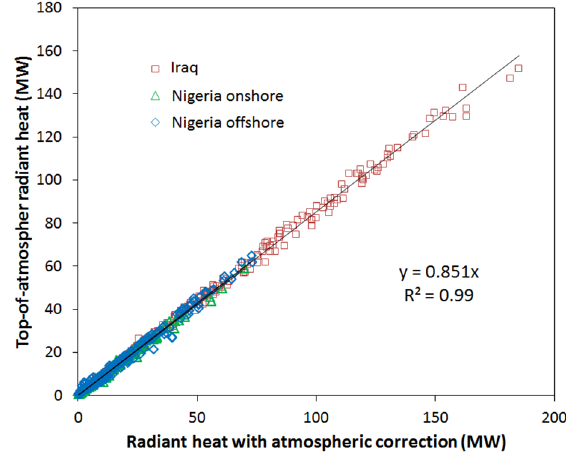
Figure 4. Radiant heat ( RH ) for three gas flares, with and without atmospheric correction. Sites include onshore and offshore flares in Nigeria (moist atmosphere) and a flare in Iraq (dry atmosphere).